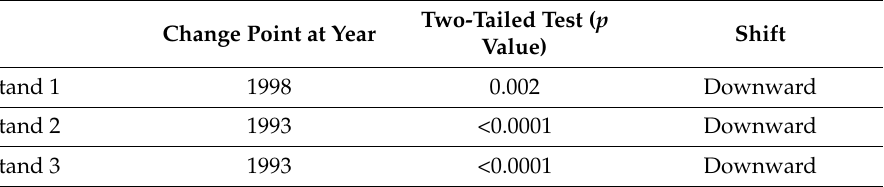
Figure 3. Graphical representation of the Average Ring Width Index against April and June Total Precipitation across the stands S1, S2, S3.